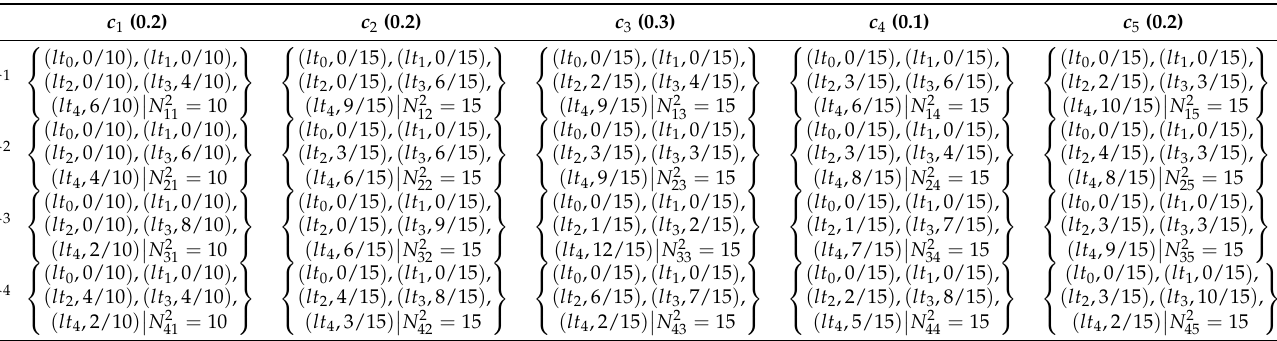
Table 2. LDAs decision matrix of d 2